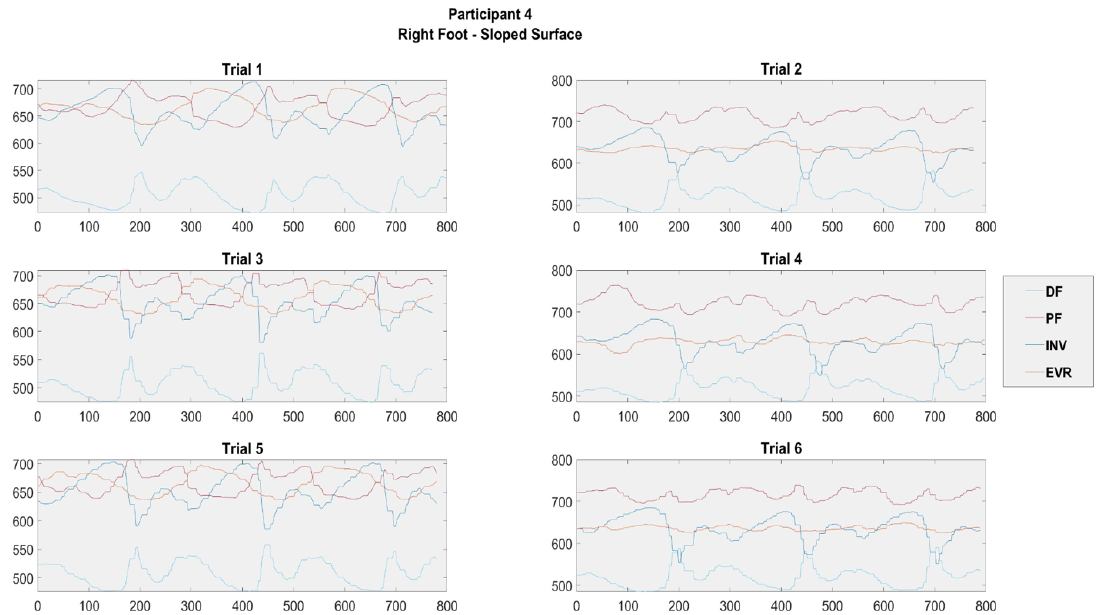
Figure 8. Data from the right foot SRS in the sloped surface experiment performed by participant 4.